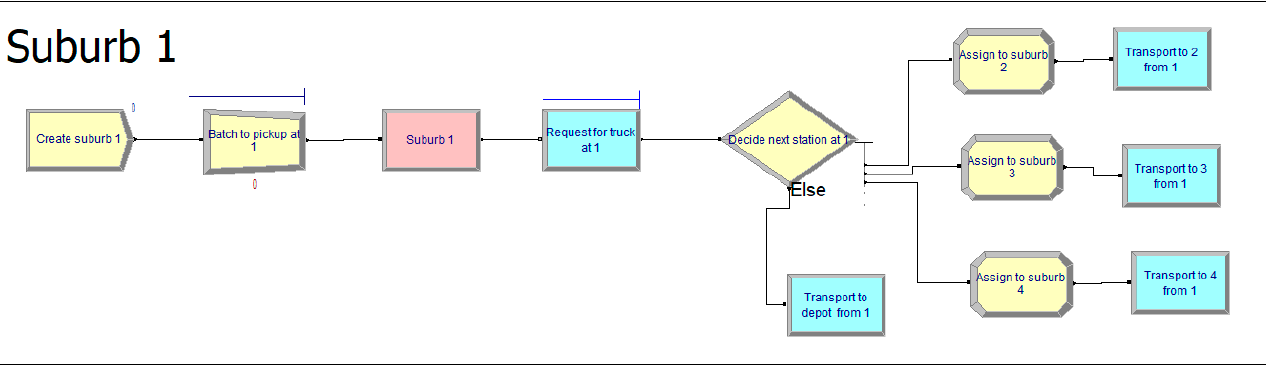
Figure 10. Initial architecture of Arena model. The image shows the architecture of one suburb.